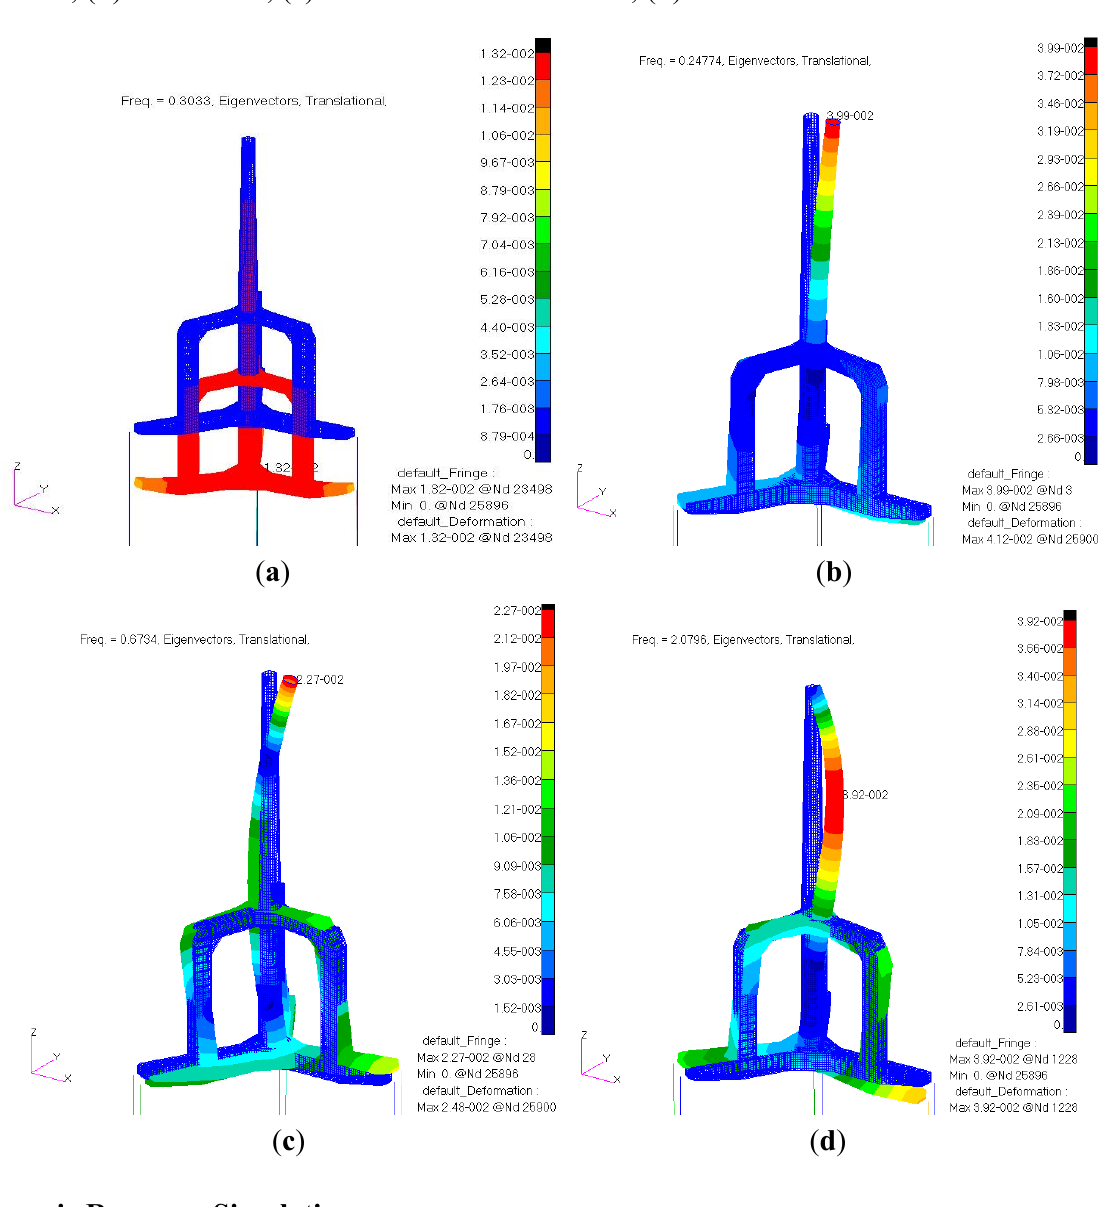
Figure 13. Mode shapes and natural frequencies of the WindStar TLP system: ( a )